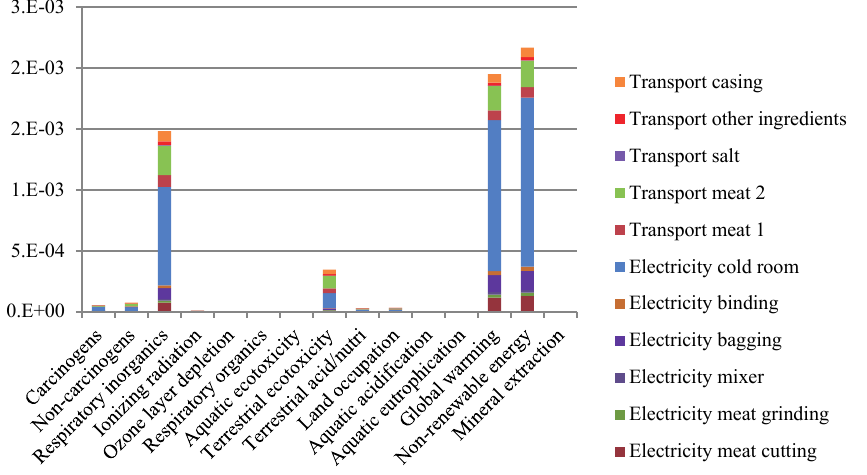
Fig. 3. Normalization impact assessment of fresh sausage – transformation phase (values in normalized points).